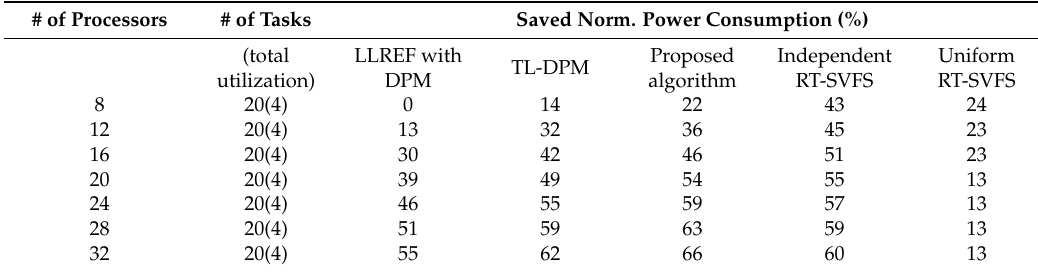
Table 5. Summary of experimental results on varying number of